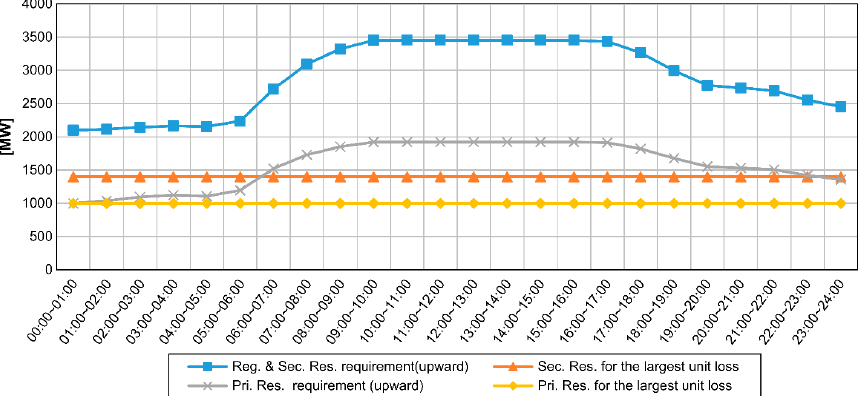
Figure 10. Spinning reserve requirement at each hour.